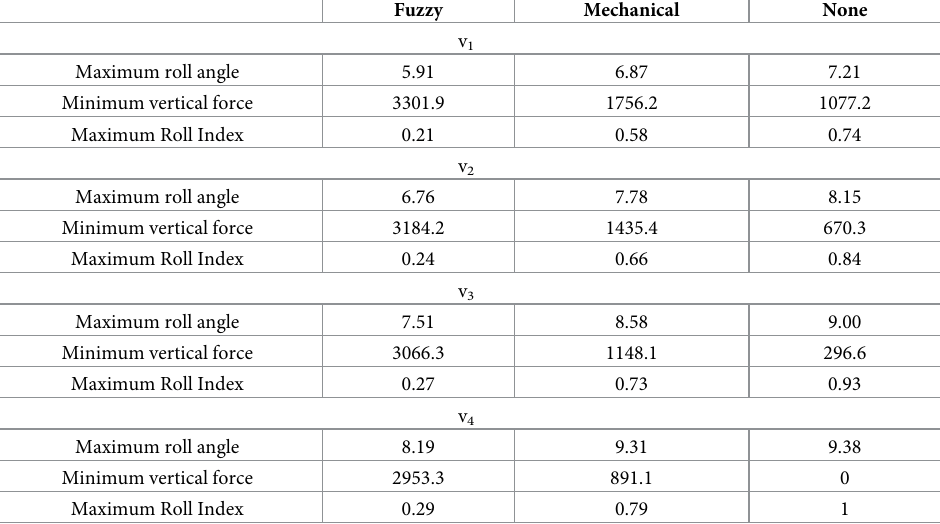
Table 4. Simulation results–Case